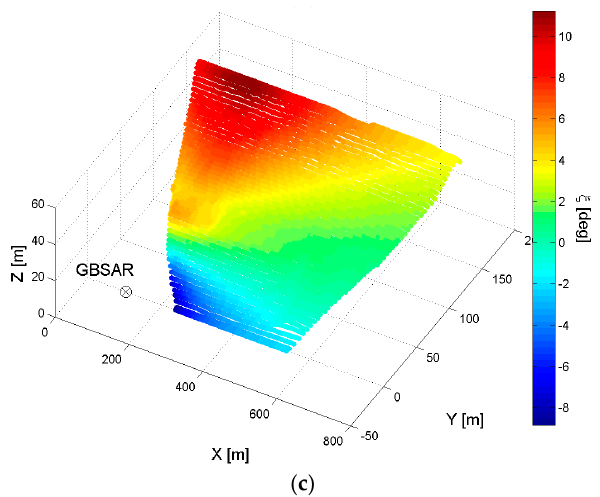
Figure 2. ( a ) Range distance R ; ( b ) azimuth angle ψ ; ( c ) vertical angle ξ .